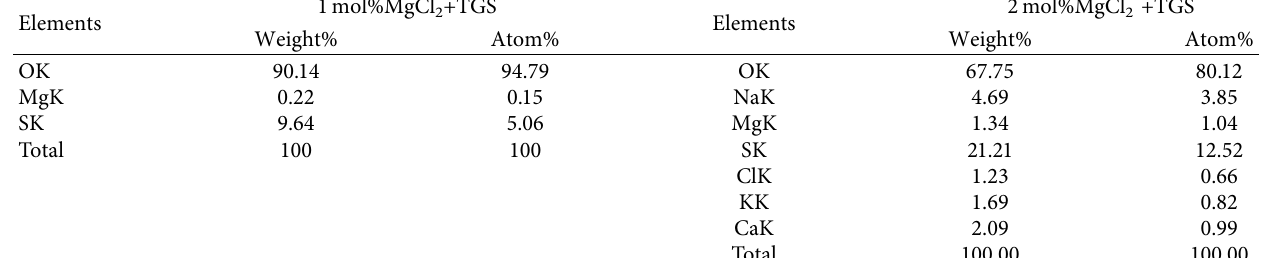
Table 1: Energy dispersive X-ray (EDX) analysis.